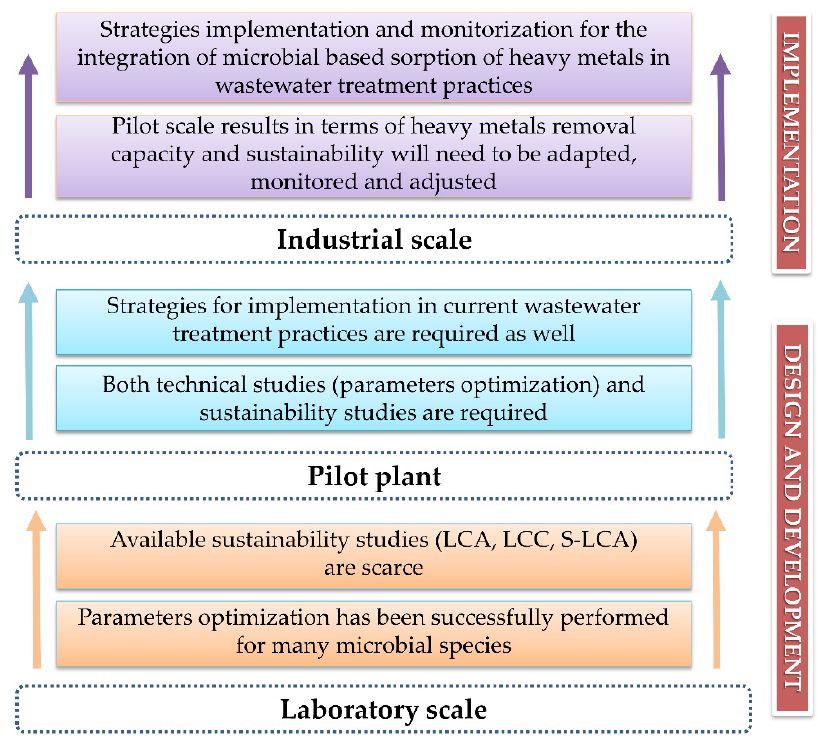
Figure 8. Life-cycle sustainability assessment status research from a lab scale to industrial scale concerning metal removal from wastewaters using microorganisms.